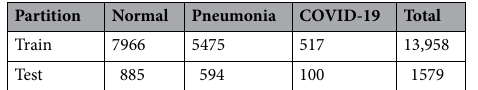
Table 1. COVIDx V5 chest radiography images